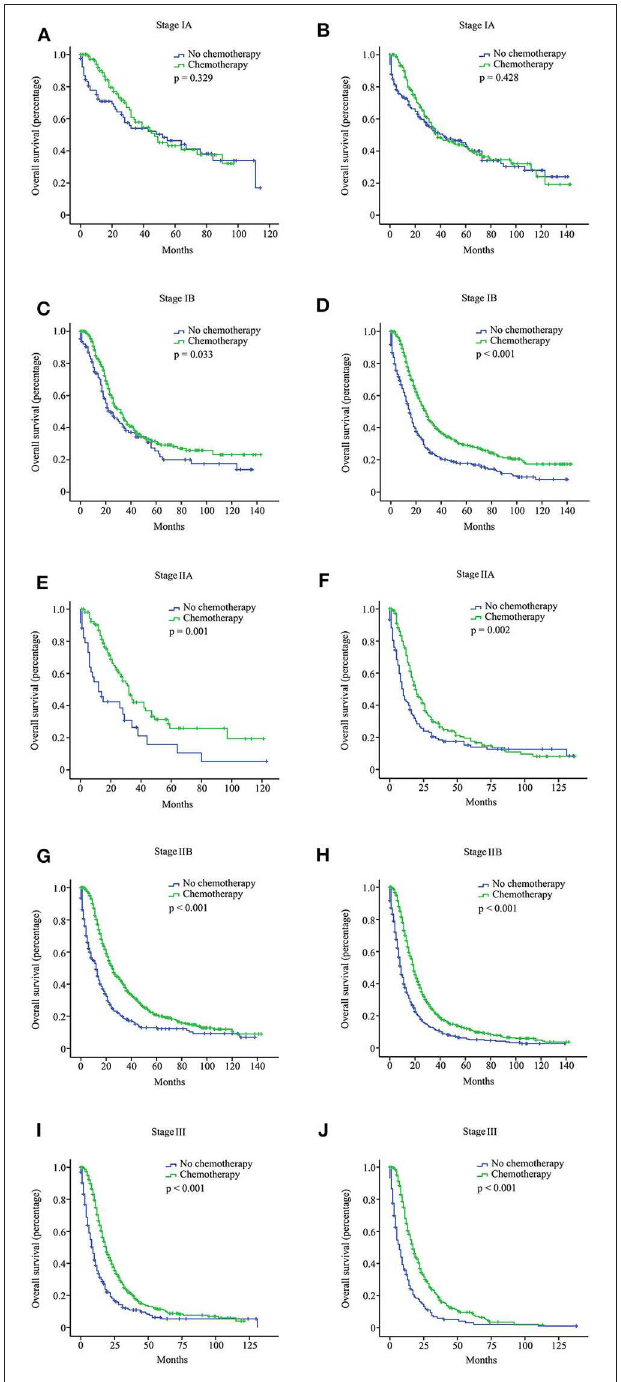
FIGURE 1 | Overall survival (OS) curves for pancreatic ductal adenocarcinoma (PDAC) patients with different stages from the Surveillance, Epidemiology, and End Results (SEER) database according to the 8th American Joint Committee on Cancer (AJCC) staging system. Stage IA with 15 or more resected lymph nodes (A) ; stage IA with < 15 resected lymph nodes (B) ; stage IB with 15 or more resected lymph nodes (C) ; stage IB with < 15 resected lymph nodes (D) ; stage IIA with 15 or more resected lymph nodes (E) ; stage IIA with < 15 resected lymph nodes (F) ; stage IIB with 15 or more resected lymph